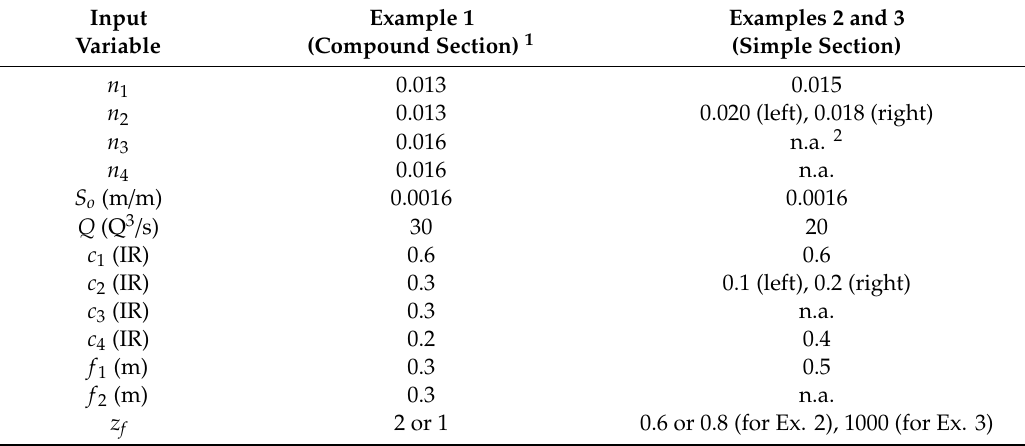
Table 4. Input data for Examples 1 and 2.